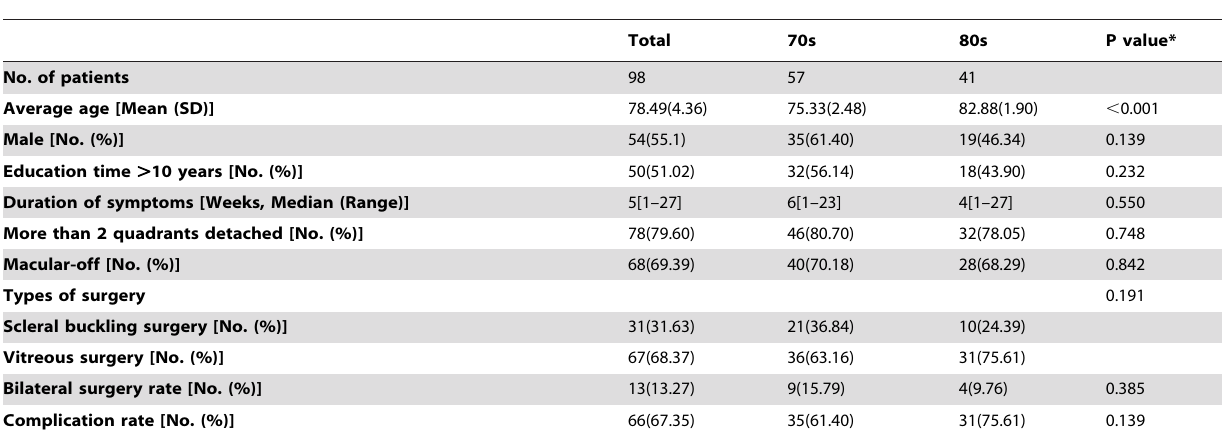
Table 1. Characteristics and surgical data for 98 elderly RRD patients.